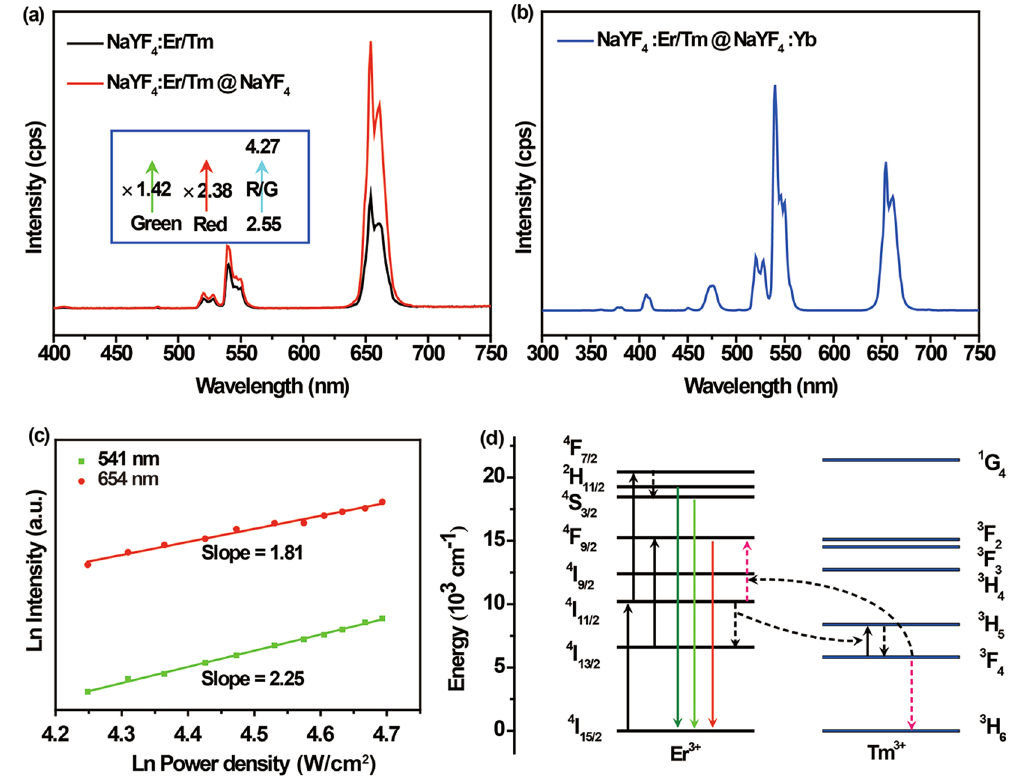
Figure 2. Photoluminescence features of the upconversion nanoparticles. ( a–b ) The emission spectra of nanoparticles under CW 980 nm diode laser excitation: ( a ) NaYF 4 :Er/Tm, NaYF 4 :Er/Tm@NaYF 4 and ( b ) NaYF 4 :Er/Tm@NaYF 4 :Yb; ( c ) Excitation power density dependence at 541 nm and 654 nm of NaYF 4 :Er/Tm@